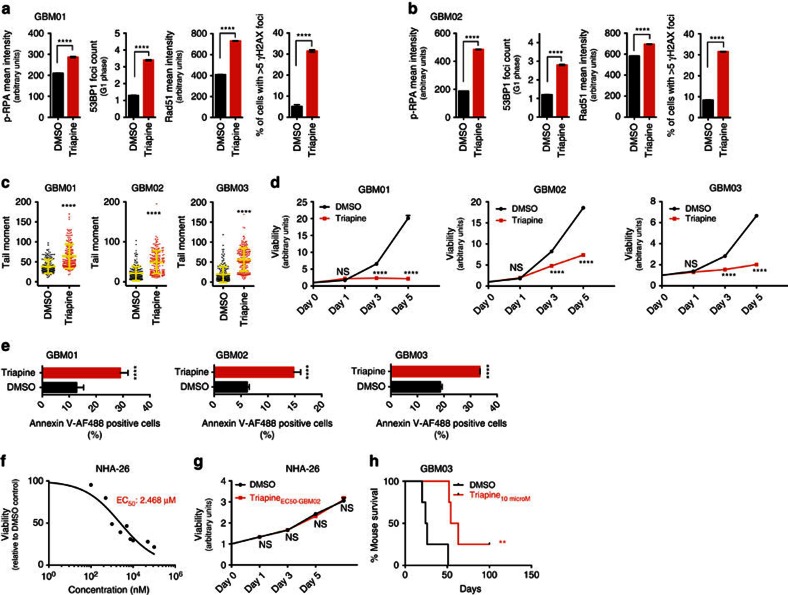
RRM2 inhibition using triapine selectively kills GBM cells and impairs tumour initiating capacity of GBM cells.(a) Quantification of p-RPA/ Rad51, 53BP1 and γH2AX in GBM01 cells treated with DMSO or triapine. (b) Quantification of p-RPA/Rad51, 53BP1 and γH2AX in GBM02 cells treated with DMSO or triapine. (c) Comet assay and tail moment quantification of DSBs in GBM cells treated with DMSO or triapine. (d) Viability curves for GBM01, GBM02 and GBM03 cells treated with their respective EC50 triapine concentrations over a period of 5 days. (e) Quantification of apoptotic cells for GBM01, GBM02 and GBM03 cells treated with their respective EC50 triapine concentrations 72 h. (f–g) Viability-based assessment of EC50 triapine concentration in NHA-26 cells and viability curve of NHA-26 cells treated with triapine EC50-GBM02. (h) Kaplan-Meier survival curve for NMRI nude mice intracranially co-injected with GBM03 cells in DMSO or 10 μM triapine. Statistical significance was calculated by one-way ANOVA, Tukey’s multiple comparisons test (in vitro studies) and Log-rank/Mantel-Cox test (in vivo study). All data are shown as means ±s.d. and performed as technical triplicates. (*P<0.05, **P<0.005, ***P<0.005, ****P<0.0001; NS represents non-significance).